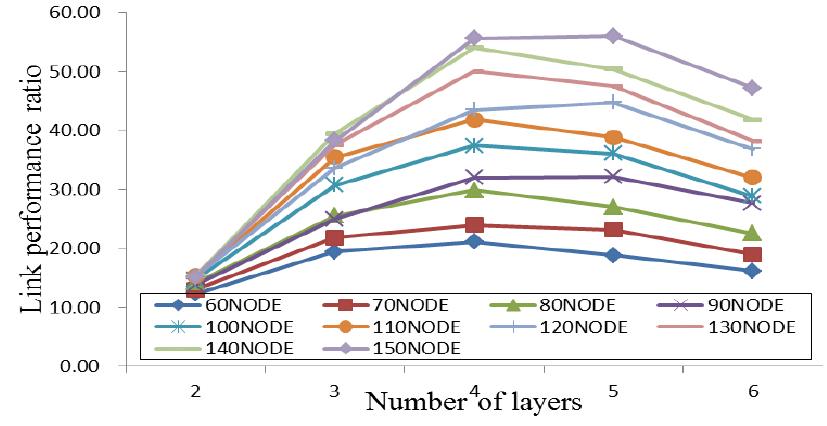
Figure 6. The link performance ratio of peak-search examples.